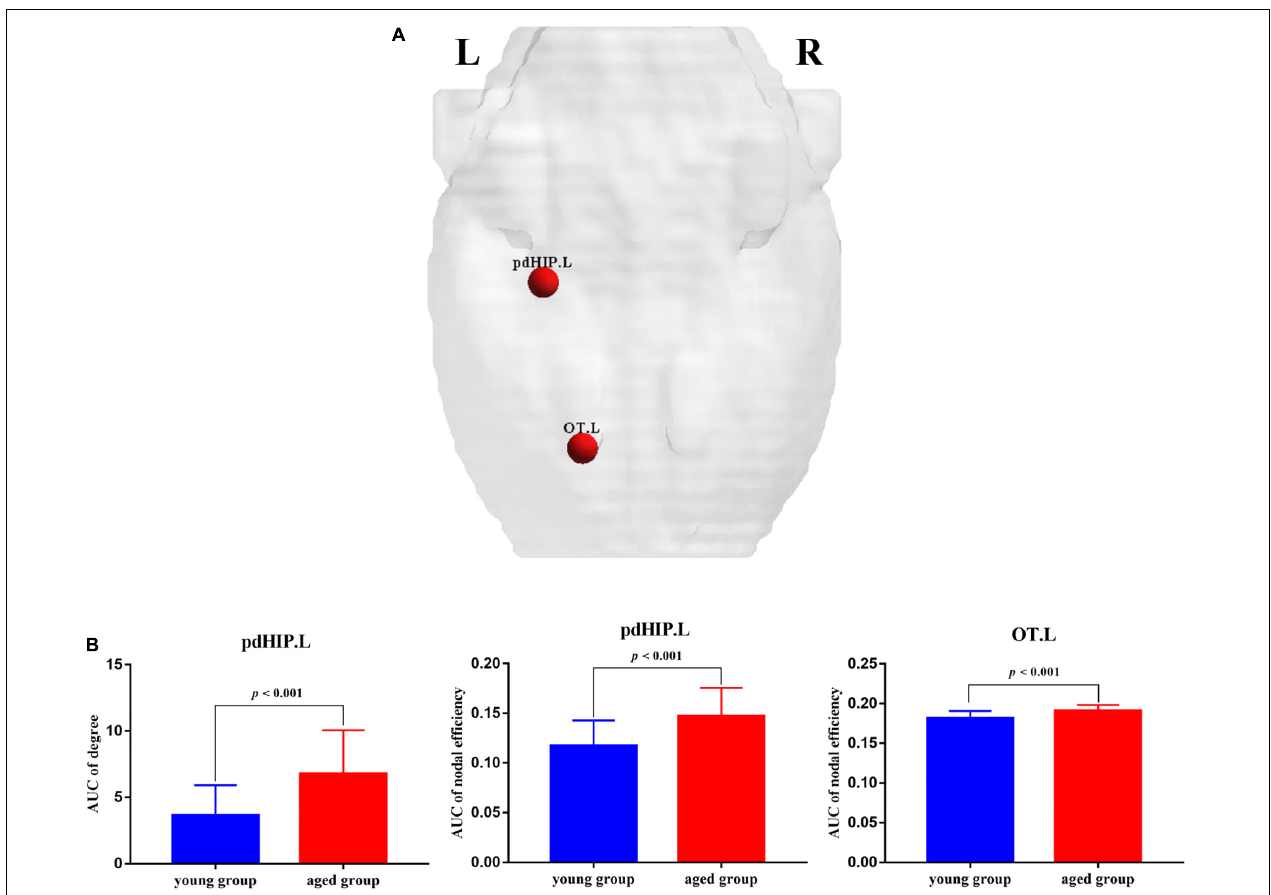
FIGURE 2 | The nodes showed significant changes in regional properties between the young rats and the aged rats. (A) Red spheres indicate nodes with increased nodal properties in the aged rats. (B) The bar plots display the mean (standard error) of degree and nodal efficiency values of pdHIP.L and OT.L for each group. pdHIP.L, left posterior dorsal hippocampus; OT.L, left olfactory tubercle.